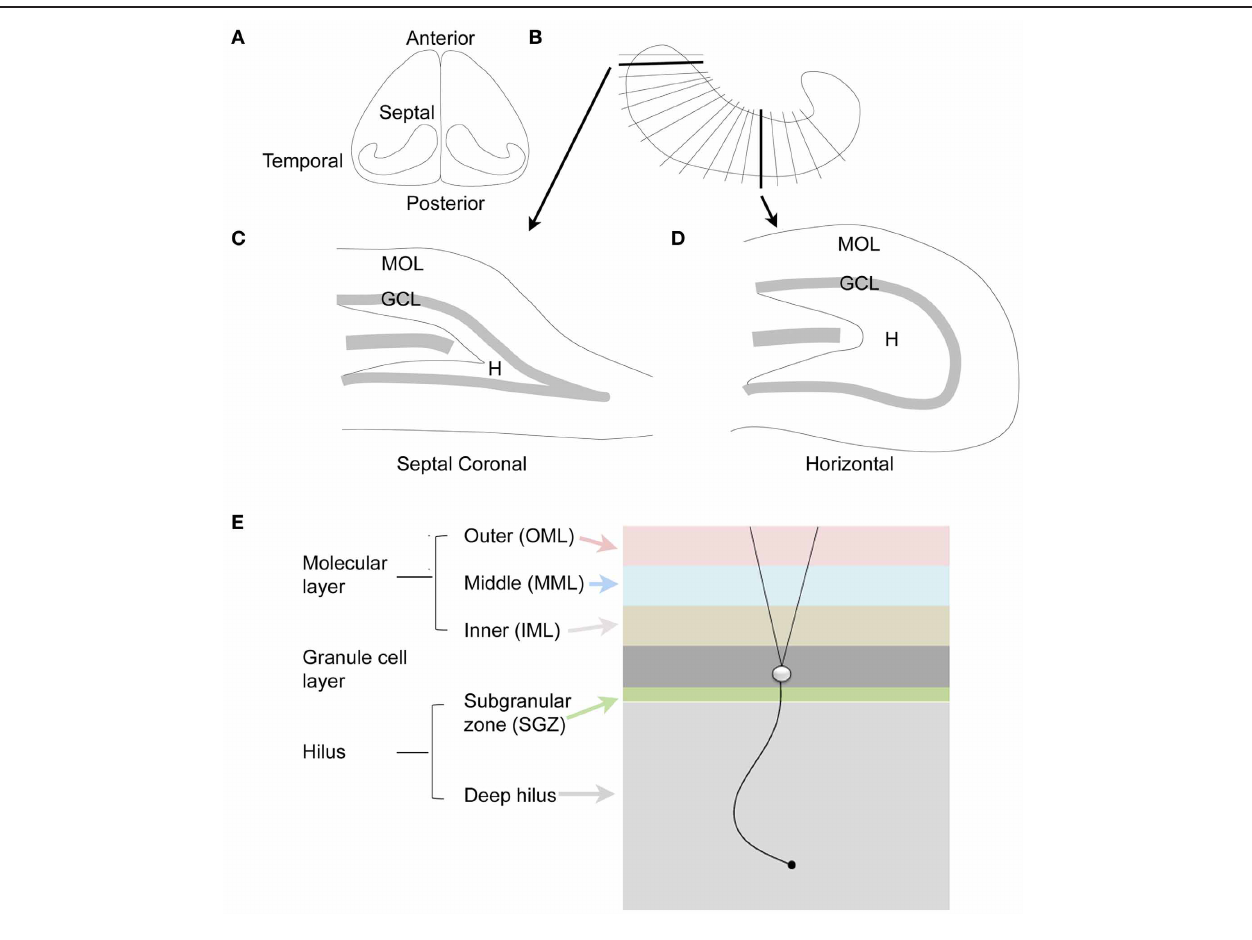
a mossy fiber. The molecular layer is divided into three zones that are approximately the same width: outer molecular layer (light red); middle molecular layer (light blue); and inner molecular layer (light brown). The granule cell layer (dark gray) has several layers of densely-packed granule cells. Below the granule cell layer is a small subgranular zone (light green) containing hilar neurons and precursors of granule cells. The hilus includes the subgranular zone and a larger area that ends with area CA3c. The zone near CA3c is sometimes called the deep hilus (light